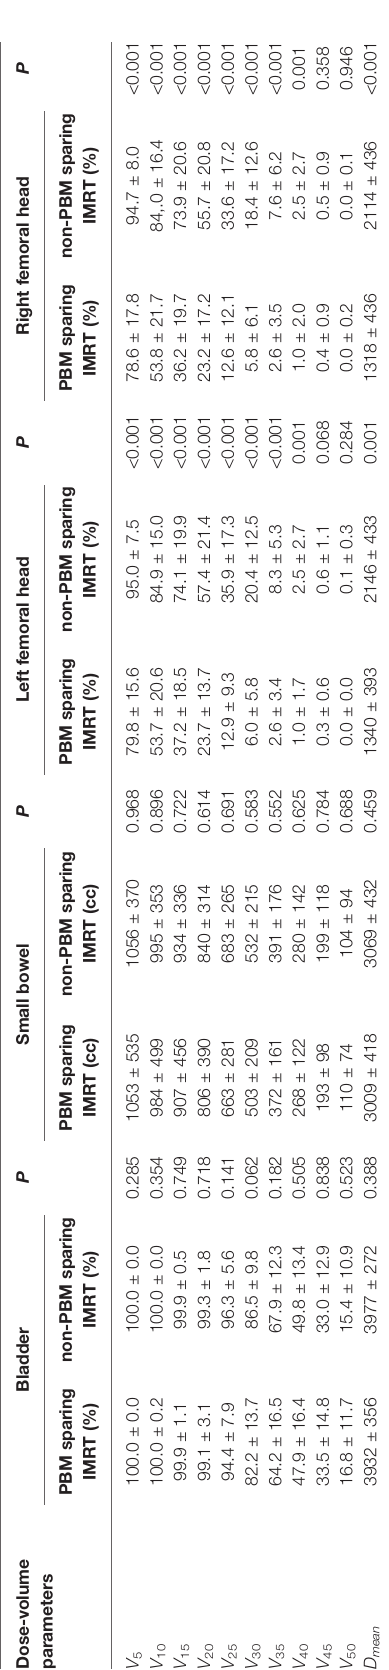
TABLE 2 | Comparison of the PTV dose distribution between the PBM sparing IMRT group and the non-PBM sparing IMRT group. D 2 (Gy) D 98 (Gy) HI* CI*